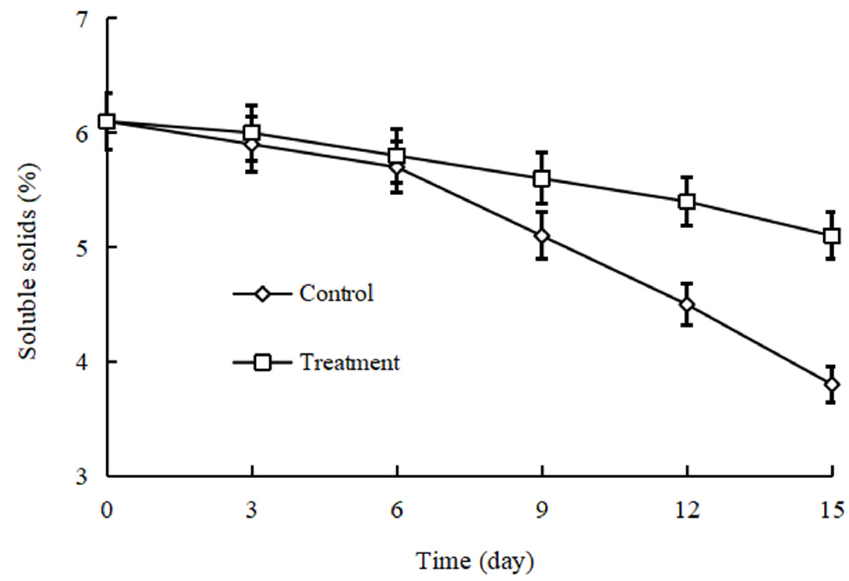
Figure 5. Effect of pullulan-based coatings on soluble solids in cowpeas during refrigerated storage. Bars represent the standard deviation ( n = 6).